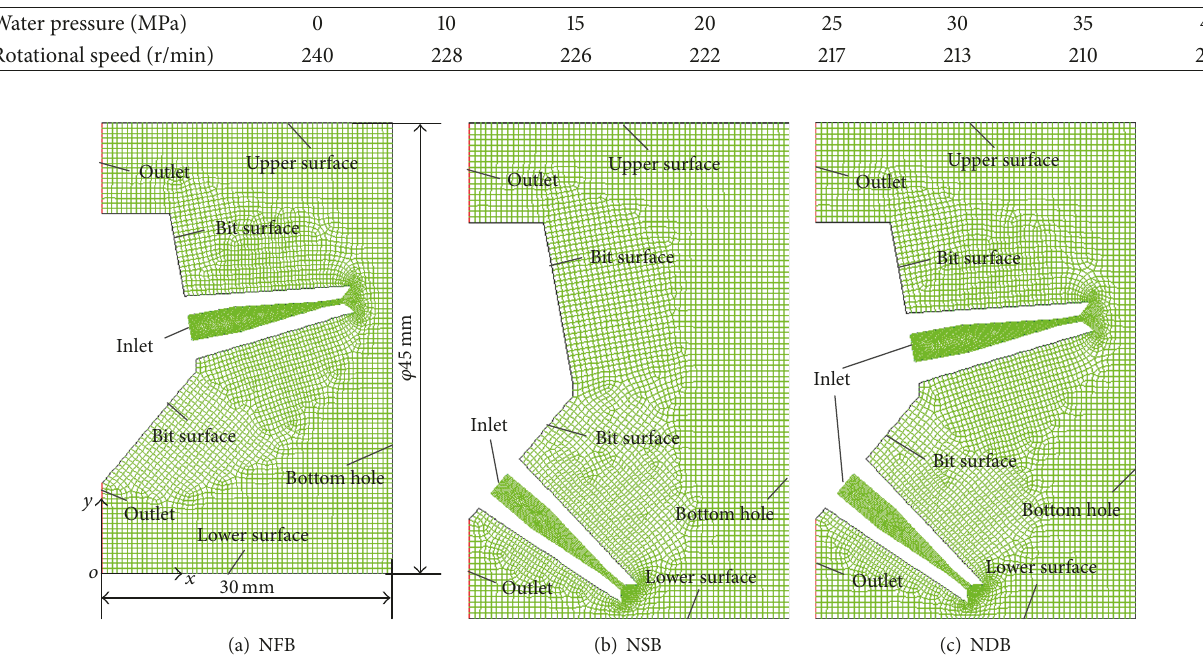
Figure 9: Two-dimensional simulation model of different configuration